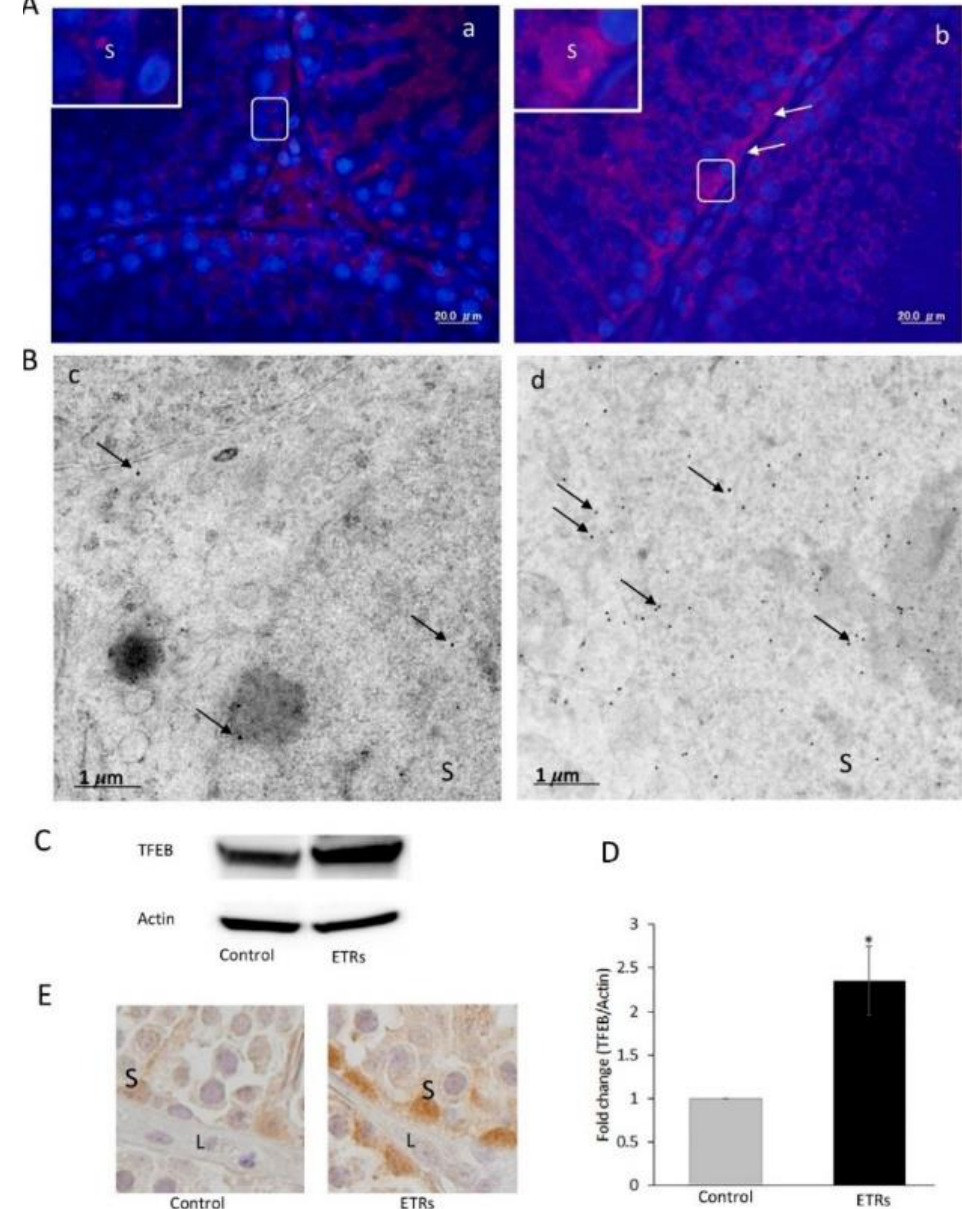
Figure 4. Elevated expression and nuclear translocation of TFEB in ETR SCs. ( A ) The IF of TFEB expressions in the control (a) and ETRs (b). The insets present higher magnifications of the framed areas. Note the overexpression of TFEB (white arrows) in the SC nuclei of ETRs. ( B ) Immunogold labeling of TFEB (black arrows, 15 nm gold particles) in the control (c) and ETR SCs (d). ( C ) Western blot of TFEB in the control and ETR tests (n = 3). ( D ) Histogram showing a significant increase in TFEB expression in the ETR tests. * p < 0.05 ( t -test). ( E ) IHC showing TFEB nuclear translocation in